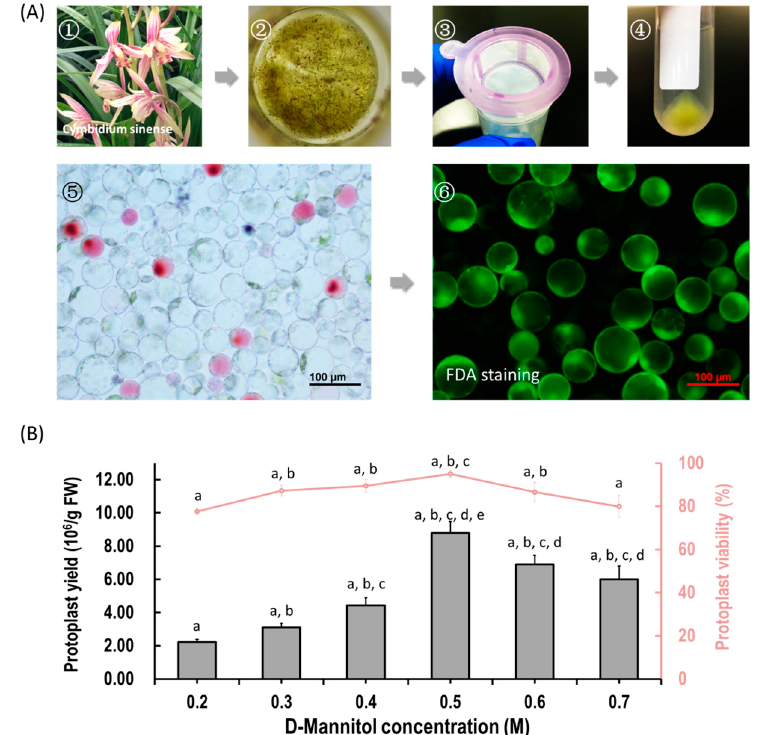
Figure 1. Protoplast isolation from flower petals of Cymbidium orchids. ( A ) Schematic illustration of protoplast isolation from Cymbidium orchids. (1) Cymbidium flower petals were collected and cut into 0.5–1.0 mm strips using fresh surgical blades on sterile filter papers; (2) immediately, transfer strips into in a 100 mL flask containing enzymatic solution; (3) after 5 h incubation at 28 ◦ C in dark, the solution containing released protoplasts were filter through a 150 µ m nylon mesh into a 50 mL round-bottomed tube; (4) following centrifuge at 200 rpm for 2 min, the protoplast pellet were re-suspended with W5 solution; (5) check the morphology and yield of protoplasts under a microscope and (6) measure the protoplast viability using the FDA staining method. ( B ) Optimization of Cymbidium protoplast isolation conditions. A series of D-mannitol concentration in the enzyme solutions (0.2, 0.3, 0.4, 0.5, 0.6 and 0.7 M) were tested for di ff erent tissues to ensure that released protoplasts do not rupture or collapse during enzyme digestion; data presented as means of three biological replicates with error bars indicating standard deviations (SD), and di ff erent letters (a–e) among treatments indicate statistically significant di ff erences at p < 0.05 based on the Tukey–Kramer